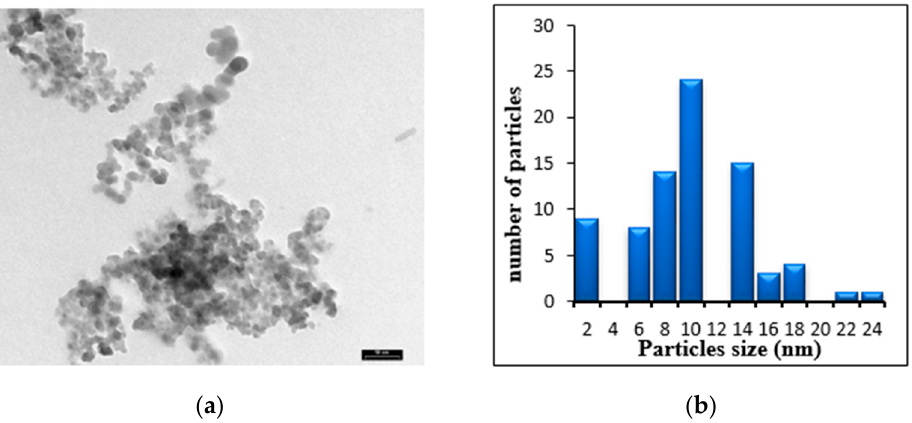
Figure 7. ( a ) TEM image of TiO 2 NPs prepared under the following laser conditions (80 mJ; 20